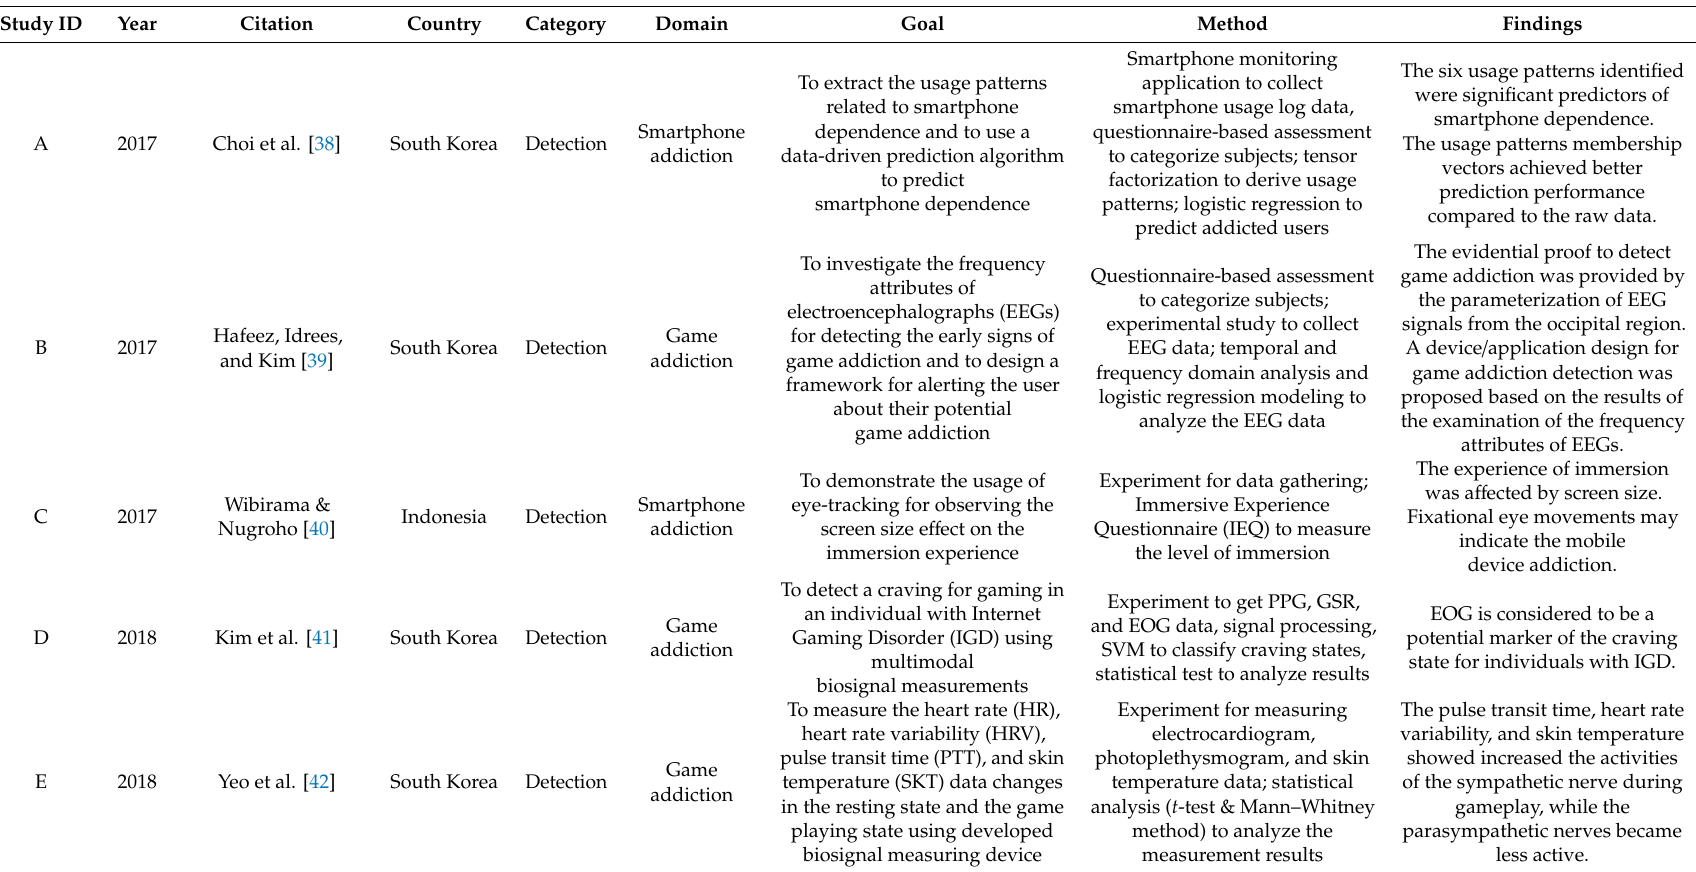
Table 1. Selected studies on the use of IT in digital addiction